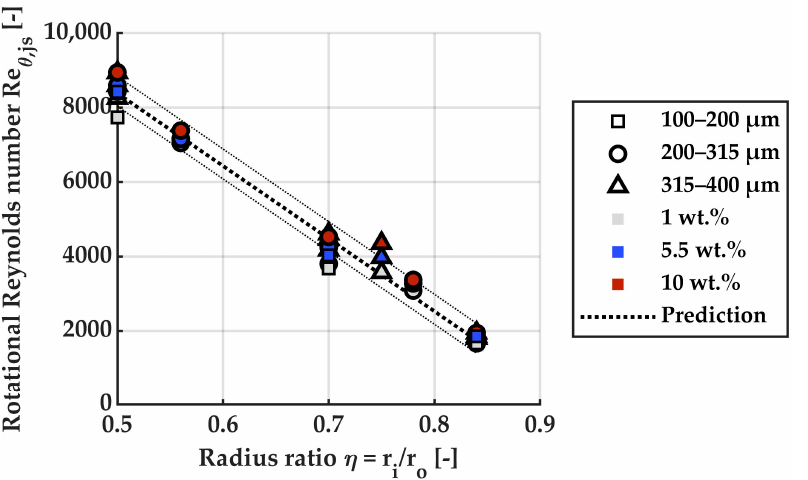
Figure 7. Just-suspended rotational Reynolds numbers for different radius ratios, particle sizes, and mass fractions. The different colors depict the different mass fractions, while the symbols differenti‑ ate between the particle sizes. The dotted lines represent the predictions of ˆ Re θ , js (Equation (18)) for the smallest (small dots), medium (big dots), and largest (small dots) investigated particle sizes and mass fractions. The axial Reynolds number was set constant to Re ax =